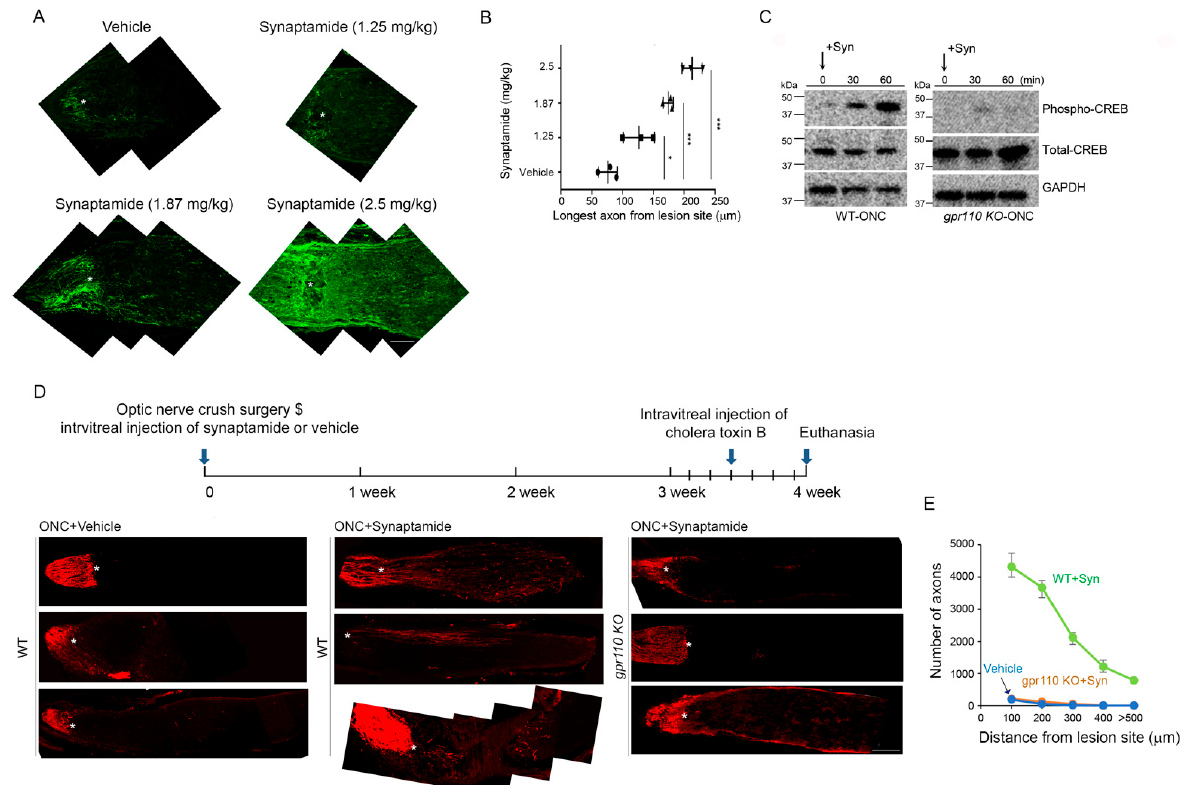
Figure 5. Synaptamide GPR110-dependently induces axon growth after optic nerve injury. ( A ) Dose-dependent effect of synaptamide on stimulated axon growth after injury. ONC was performed on 4-month-old BALB/C mice and synaptamide was administrated intravitreally at the doses indicated. Longitudinal sections through the optic nerve were collected at 4 weeks after ONC and regenerating axons were visualized by anti-GAP43 antibody (green, 1:500). Lesion site was marked by asterisks (*). ( B ) Quantitative measurement of axon length extended from the lesion site after synaptamide injection at the doses indicated. ( C ) Time-dependent increase in CREB phosphorylation after synaptamide injection into 4-month-old WT but not gpr110 KO mouse retinas following ONC. ( D ) Optic nerve tissue sections collected at 4 weeks after ONC and visualized by CTB, indicating that intravitreal injection of synaptamide (2.5 mg/kg) induced axon growth in WT but not in gpr110 KO mice. The optic nerve micrographs shown in A and at the bottom panel of the ONC+Synaptamide group in D were obtained after the manual stitching of image sections using Photoshop. ( E ) The number of the axons extended to a 100–600 micrometer distance from the lesion site, indicated by the asterisk. Data are expressed as mean ± s.e.m with n = 3 ( A ) and n = 4 ( E ) per group. * p < 0.05, *** p < 0.001 by one-way ANOVA. Scale bars, 100 µm ( A , D ).